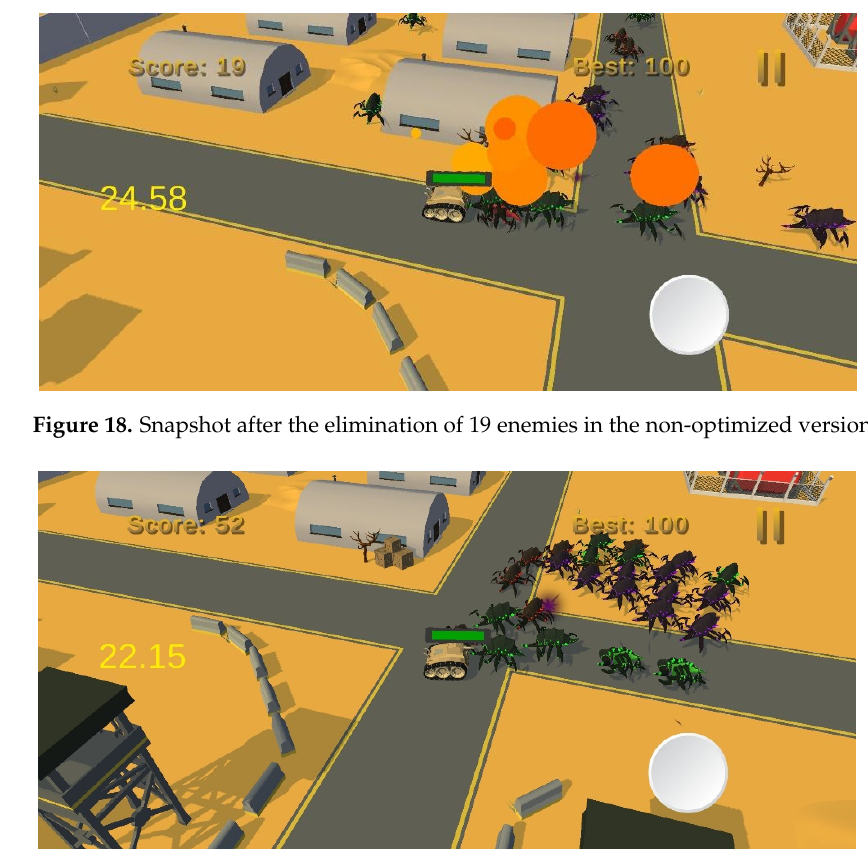
Figure 20. Snapshot after the elimination of 75 enemies in the non-optimized version of the game.